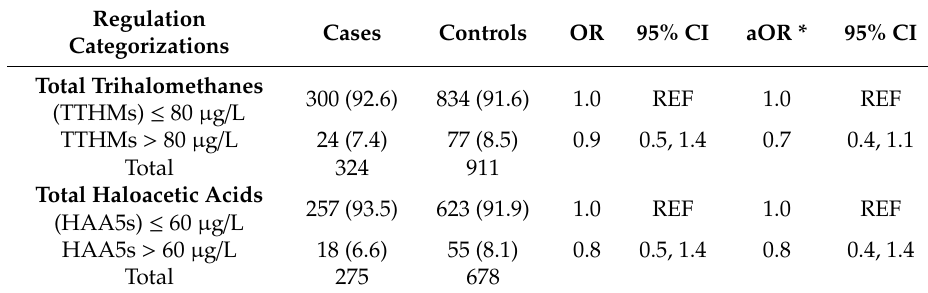
Table 3. Association between household disinfection by-product (DBP) concentrations above and below US Environmental Protection Agency (USEPA) allowable levels and hypospadias, National Birth Defects Prevention Study, 2000–2005 ( n =